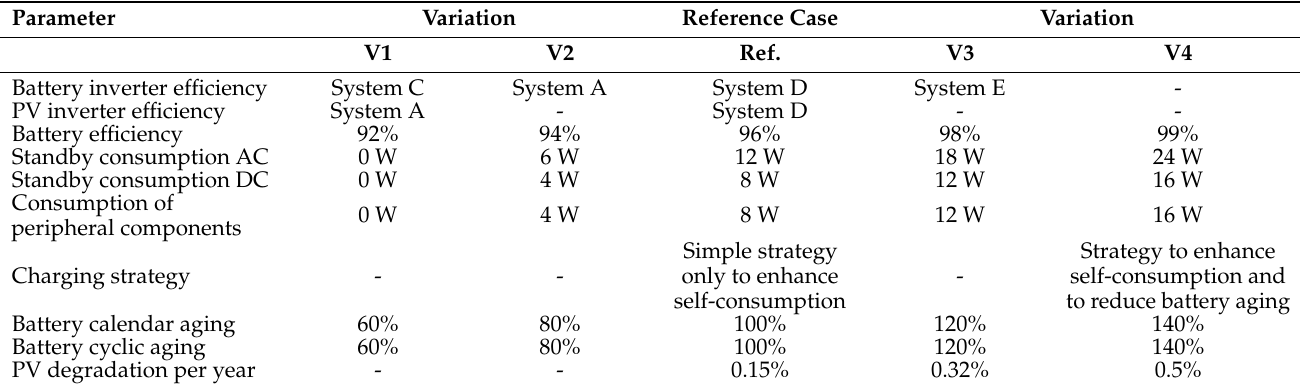
Table 4. Technical parameters studied.